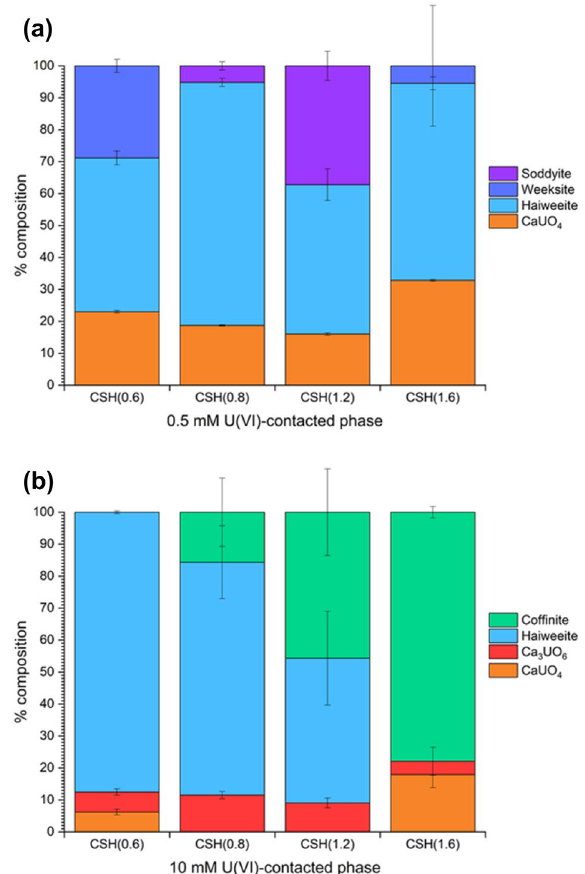
Figure 5. Linear combination fitting analysis of U L III -edge XANES. For ( a ) 0.5 mM and ( b ) 10 mM U(VI)- contacted C–S–H phases compared to the U